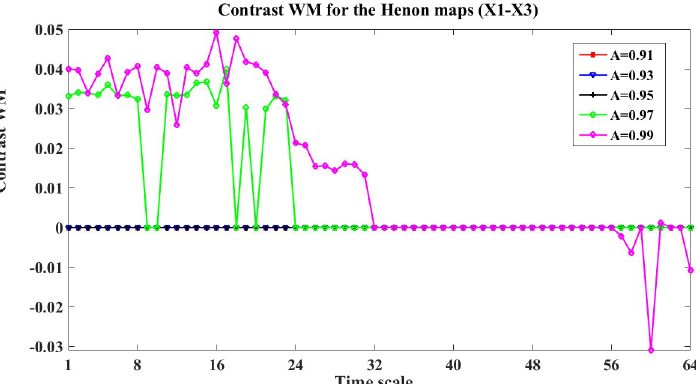
Fig 6. The contrast WM for the four unidirectionally coupled Henon maps with different stopping criteria (X1-X3). This figure shows the line plots of the contrast WM (contrast values between X1 and X3) O